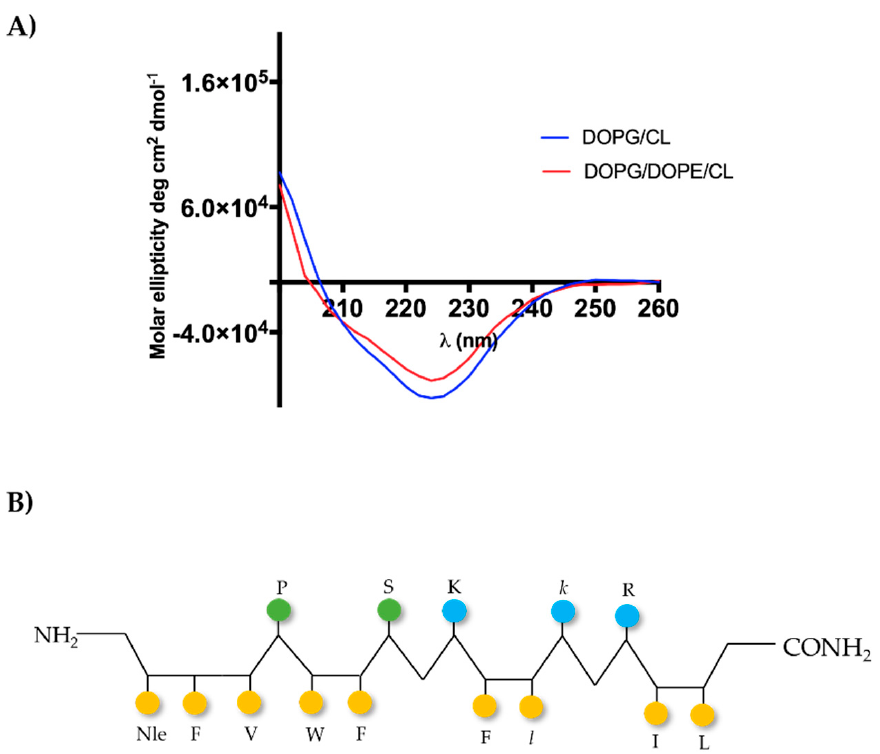
Figure 3. The panel A shows CD spectra of [Nle 1 , D Leu 9 , D Lys 10 ]TL in LUVs made of DOPG/CL and DOPG/DOPE/CL (panel A ). The (panel B ) shows the hypothetical representation of β -sheet conformation of [Nle 1 , D Leu 9 , D Lys 10 ]TL, where yellow circles indicate hydrophobic residues, blue ones positively charged amino acids, and green the other amino acids.